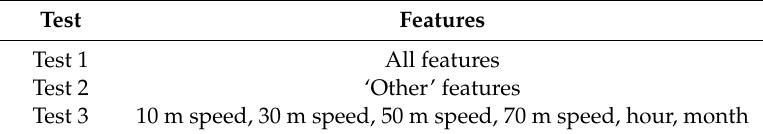
Figure 15. Feature importance at 10 m ( a ), 30 m ( b ), 50 m ( c ), and 70 m ( d ). ‘spd_10 m’ represents the 10 m wind speed output of the WRF model; ‘tmp’ represents the temperature features; ‘dir’ represents the direction features; and ‘u’ and ‘v’ represent the U and V components of wind speed, respectively, rotated to earth coordinates. Table 13. Feature importance sensitivity test